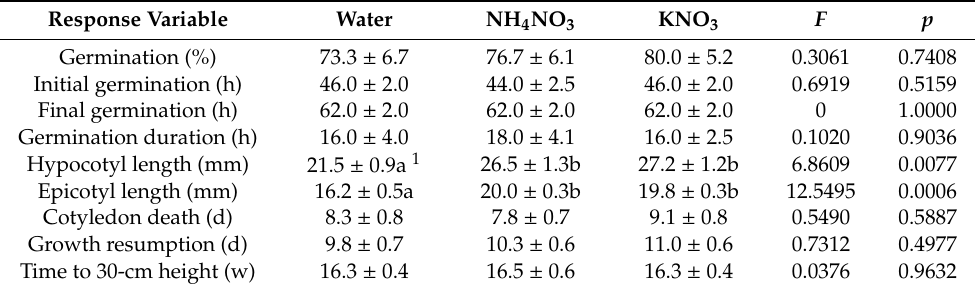
Table 3. The influence of imbibing Serianthes nelsonii seeds with water or 3000 mg / L ammonium nitrate or potassium nitrate on germination in darkness and seedling traits. Mean ± standard error. Six replications, five seeds